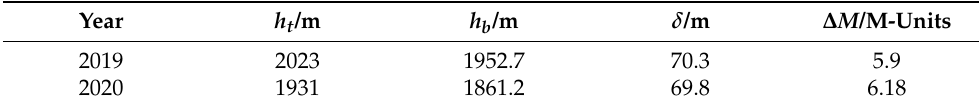
Table 3. Characteristic parameter distribution of elevated